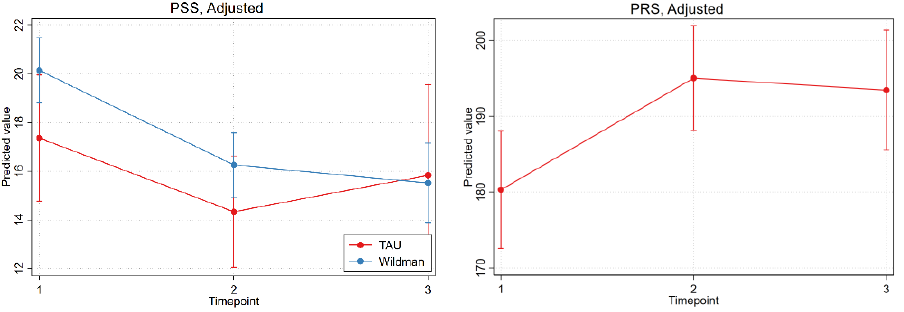
Figure 4. Adjusted analyses and the development in PSS between the participants in the intervention group and the control group and the development in PRS for the intervention group.